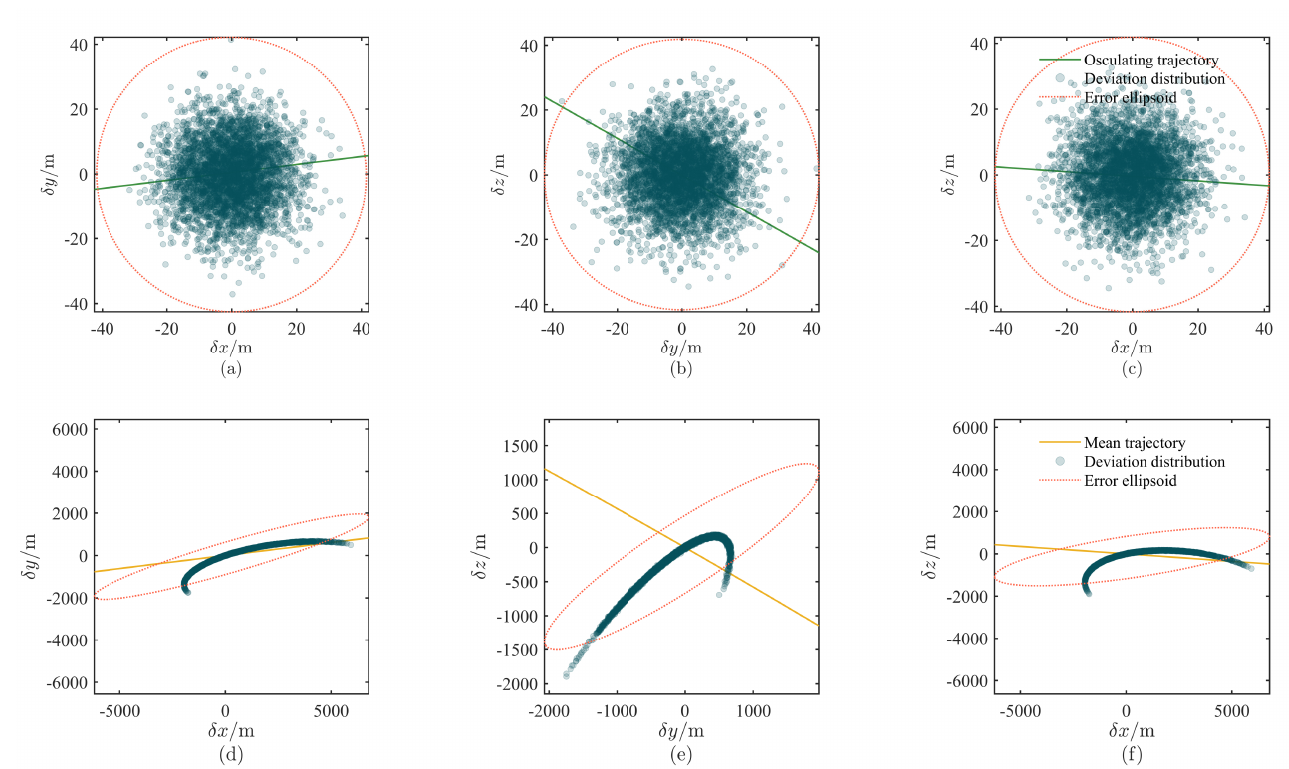
Figure 2. Initial uncertainty distribution before ( a – c ) and after ( d – f ) conversion from osculating elements to mean elements.